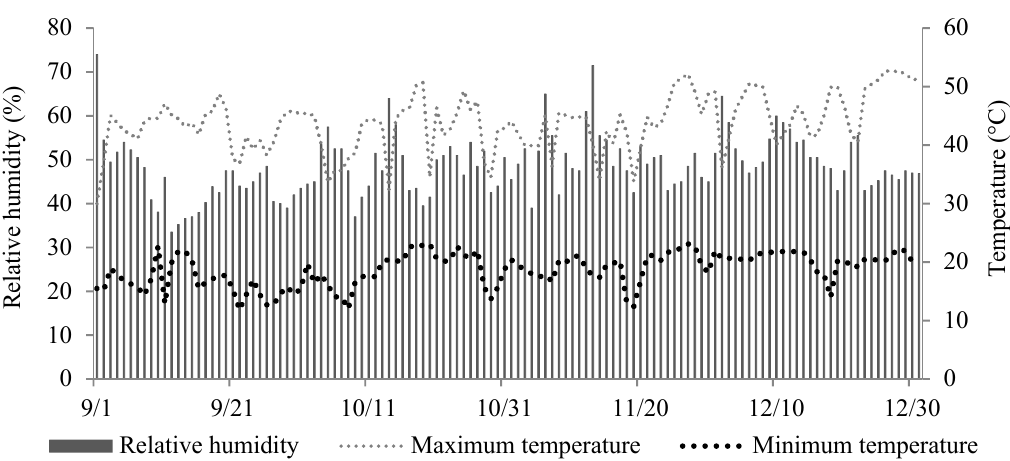
Figure 1. Daily mean values of relative humidity and maximum and minimum temperature within the greenhouse during the experimental period.